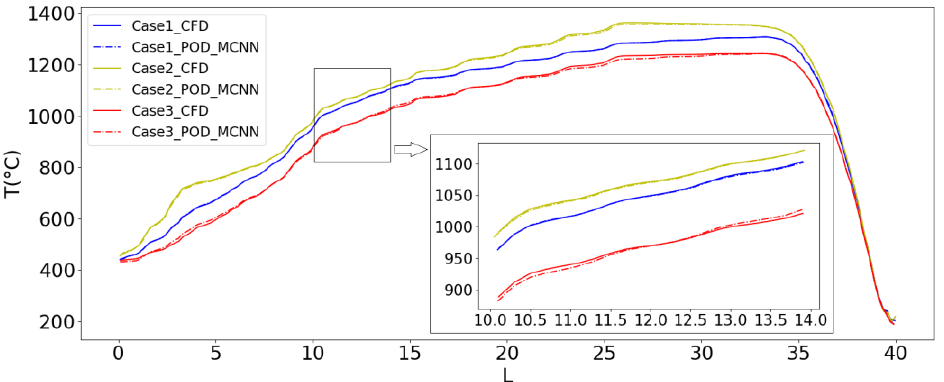
Table 3. MAE for three cases on the new data.